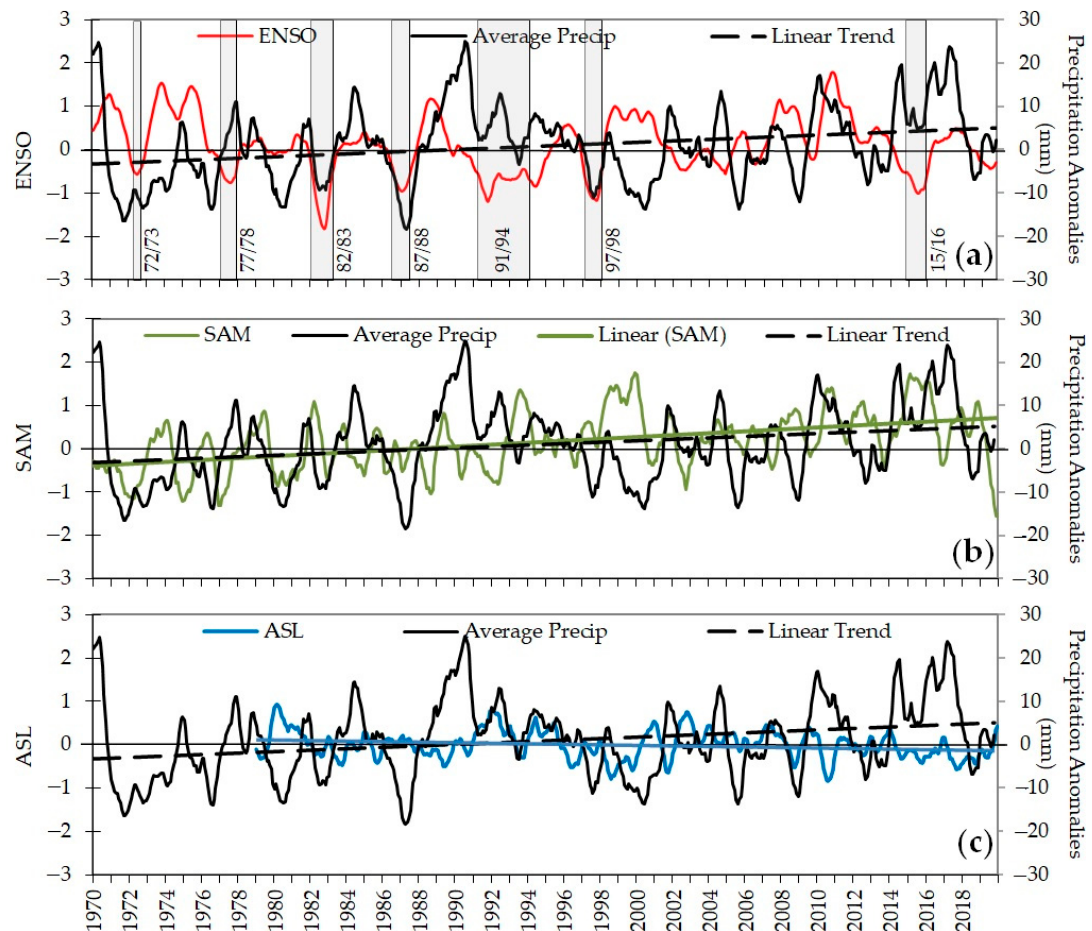
Figure 10. Monthly precipitation anomalies of the areal average from Frei, Prat, and O’Higgins weather stations along with the Southern Oscillation Index (SOI) ( a ), the Southern Antarctic Mode (SAM) ( b ), and the Amundsen Low Sea (ASL) ( c ) indices. The original data have been smoothed using Equation (1).